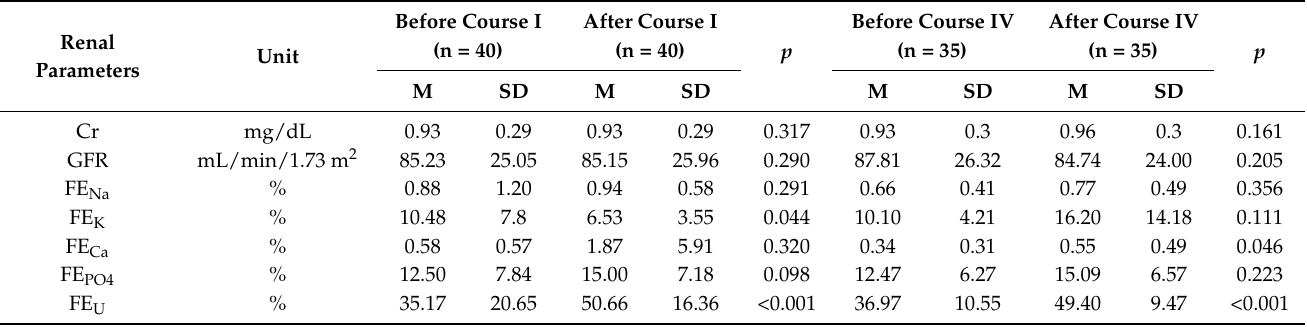
Table 2. Renal parameters before and after courses I and